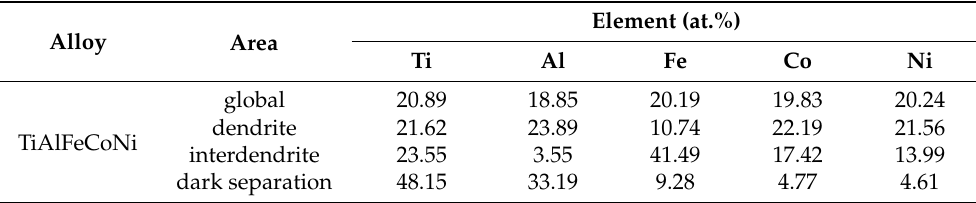
Figure 3. SEM images of TiAlFeCoNi alloy, magnification: ( a ) 1000×, ( b ) 2000×, ( c ) 5000×. Table 4. The chemical composition of TiAlFeCoNi high-entropy alloy.